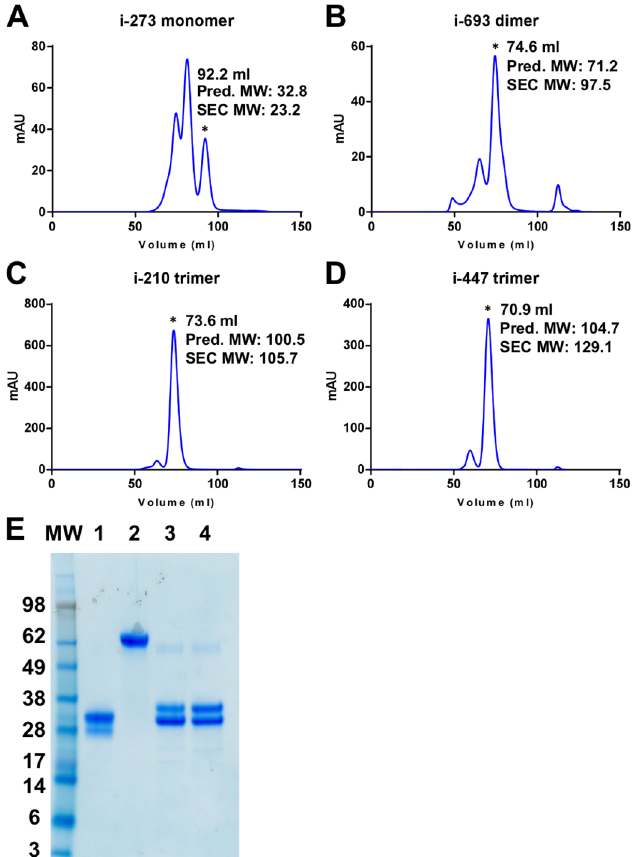
each immunogen an asterisk indicates the peak that was chosen for antigenic, physical, structural and immunization studies. The calculated molecular weight (MW) in kDa based on elution volume and the predicted MW based on the sequence and predicted glycan content (2.5 kDa/glycan) are also indicated. Immunogens i-273, i-693, i-210 and i-447 were predicted to have two, four, three and three glycans respectively based on the occurrence of NXT/S sequons in the sequence. (E) Reduced SDS-PAGE analysis (3 μ g/well) of immunogens (1) i-273, (2) i-693, (3) i-210 and (4) i-447 pooled from the asterisk-indicated peaks in (A-D). Doublet bands likely arise from differential